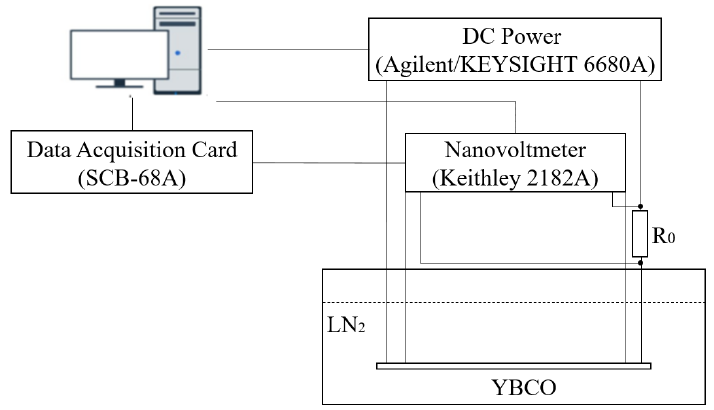
Figure 2. Schematic of the experimental